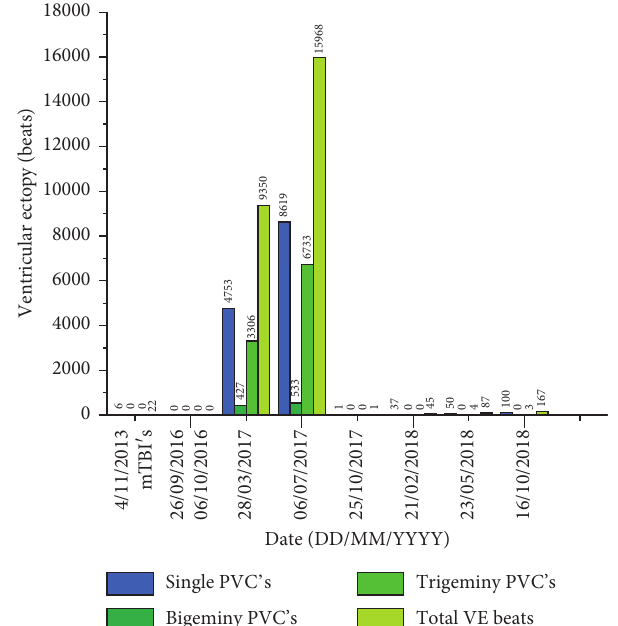
Figure 1: Total number of single premature ventricular contrac- tions (PVC), bigeminy, trigeminy, and total ventricular ectopic (VE) beats assessed during the 24-hour Holter monitor from April 2013 to October 2018. The two concussions (mTBI) are dated in the